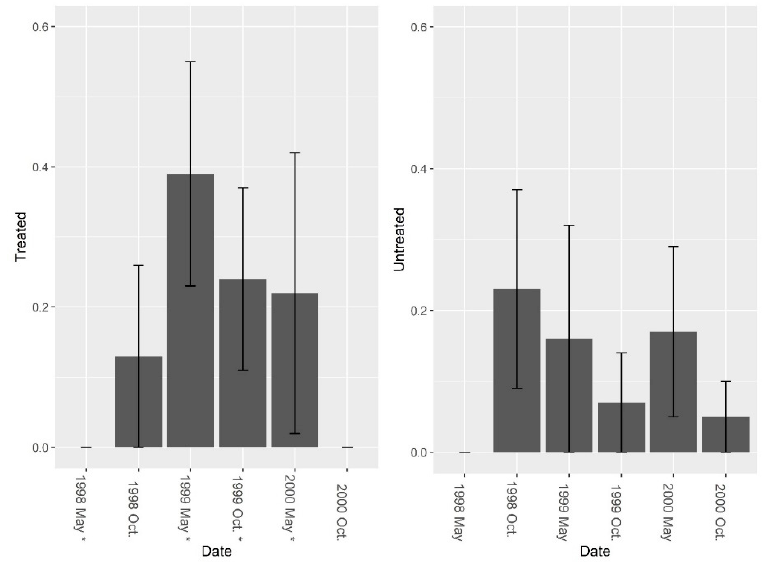
Figure 3. Mean (±1 SE) ant (excluding fire ant) species richness collected from burrow baits at five pairs of treated and untreated study sites at CSJFTC, 1998–2000. There were no significant differences between study sites from a randomized block design ANOVA (F = 1.0, df = 4, P = 0.374). Asterisks on the x ‐ axis indicate when treatments occurred.